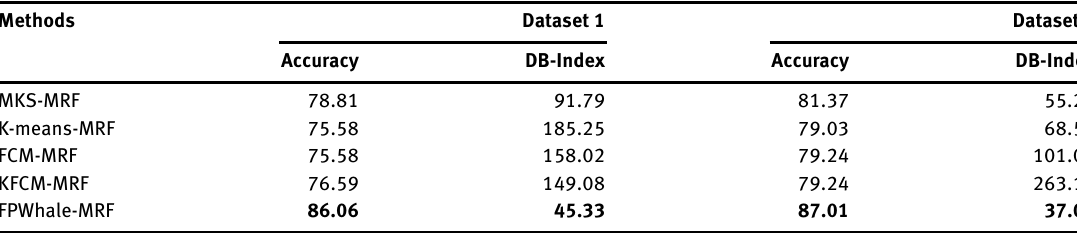
Table 5: Performance Comparison Based on the Mean